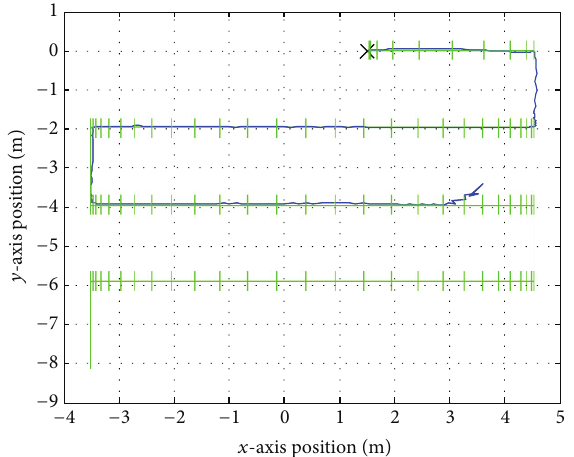
Figure 6: Planar view for nonlinear 𝐻 ∞ optimal control law with region function